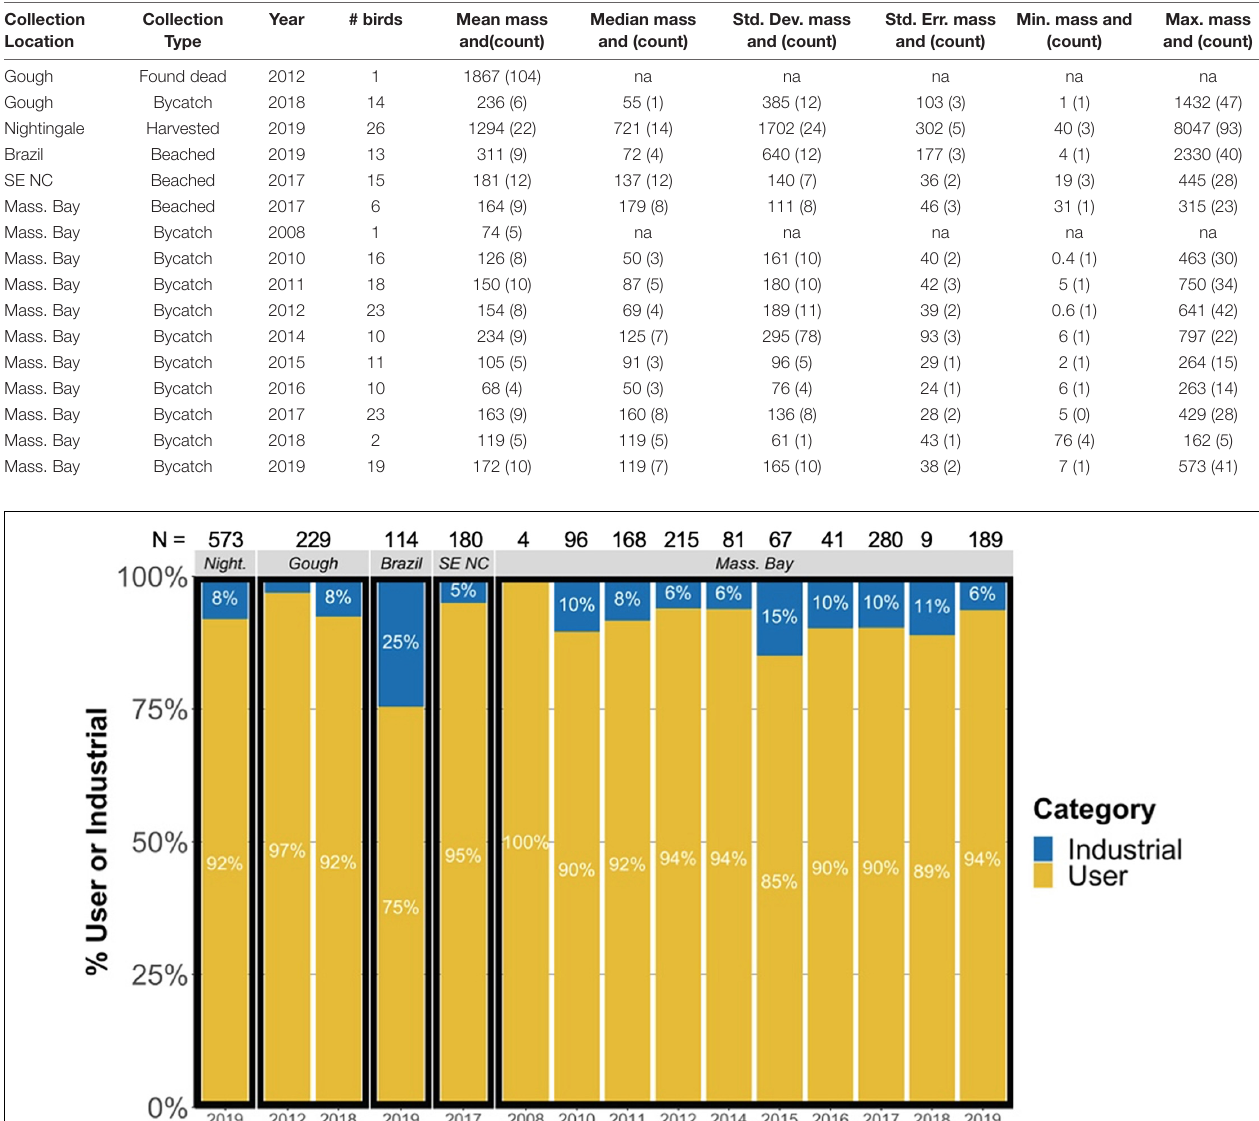
TABLE 2 | Summary statistics describing accumulated ingested plastics by mass (in mg) and count (in parentheses) observed in Great Shearwaters Ardenna gravis obtained from different regions of the Atlantic Ocean in different years.